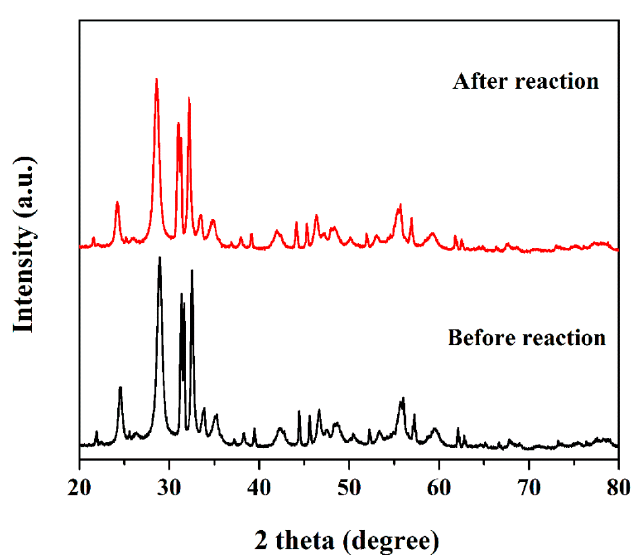
Figure 7. XRD patterns of Ag/Ag 2 CrO 4 /BiOCOOH before and after cycling tests.